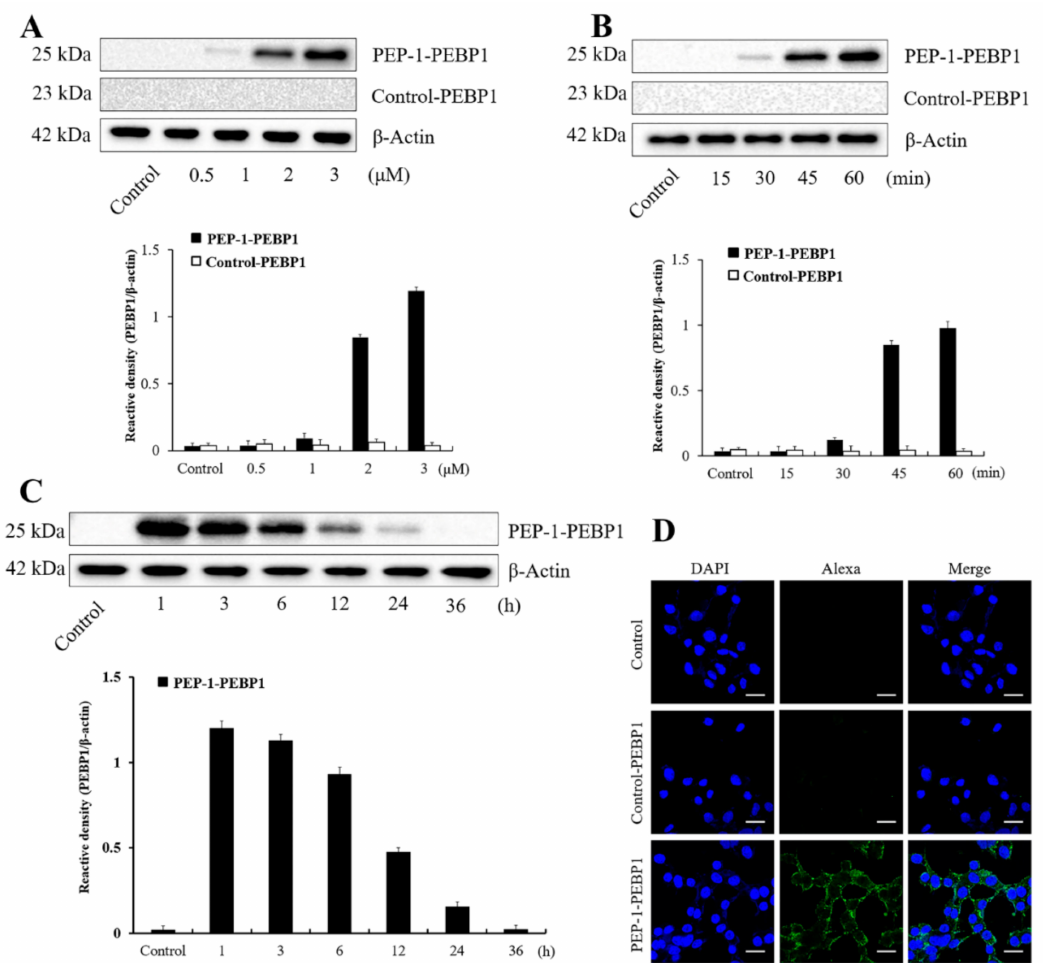
Figure 2. Transduction e ffi cacy and stability of control-PEBP1 and PEP-1-PEBP1 fusion protein in NSC34 cells. ( A ) Western blot analysis showing concentration-dependent (0.5–3 µ M) cellular expression of polyhistidine for 1 h after PEP-1-PEBP1 and control-PEBP1 treatment. ( B ) Western blot analysis showing time-dependent (0–60 min) cellular expression of polyhistidine, analyzed after 3 µ M PEP-1-PEBP1 and control-PEBP1 treatment. ( C ) Western blot analysis showing chronological (1–36 h) intracellular stability of polyhistidine expression for 1 h after PEP-1-PEBP1 treatment. ( D ) Immunocytochemical staining for polyhistidine in PEP-1-PEBP1 and control-PEBP1 protein for 1 h after PEP-1-PEBP1 treatment. Scale bar = 20 µ m. The bars indicate mean ±